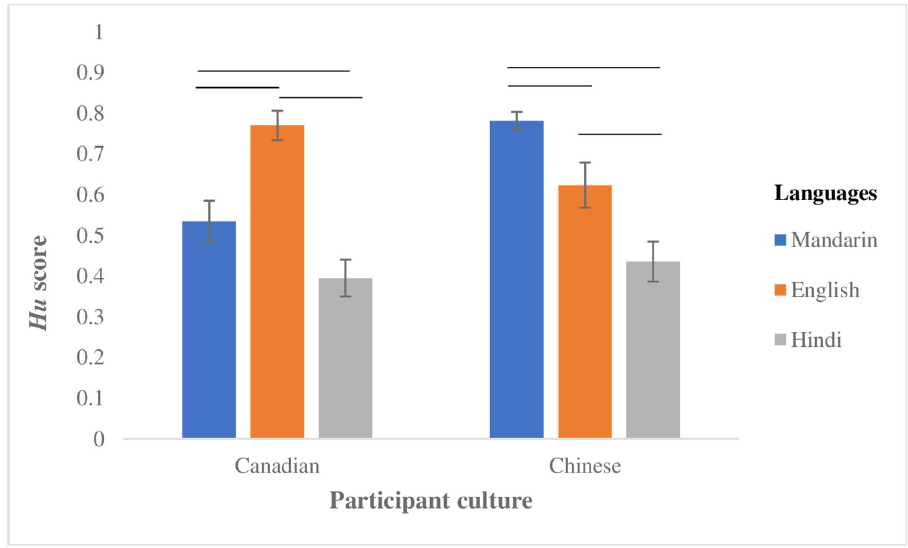
Fig 1. Effects of participant culture and language on vocal emotion recognition. The black lines above the bar graphs represent significant comparisons between different languages.